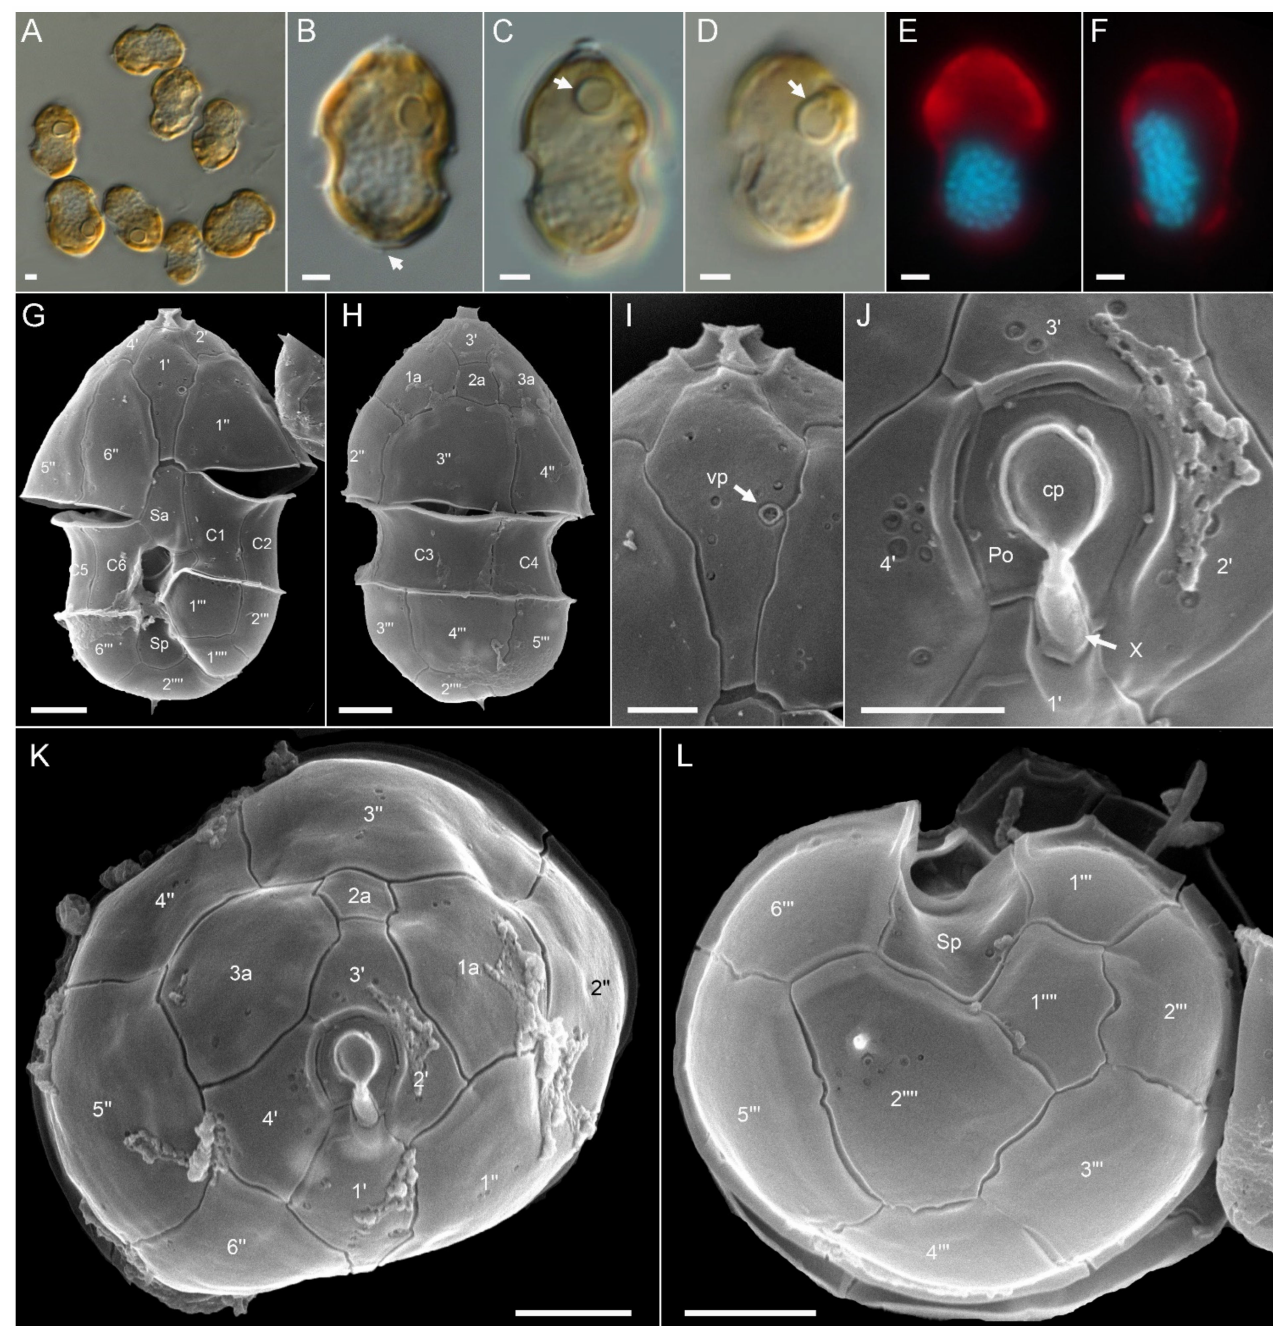
Figure 3. Azadinium spinosum ribotype A strains. ( A – D ) Light microscopy (LM) images of formalin fixed ( A , B ) or living ( C , D ) cells to indicate general size and shape. Note the antapical spine (arrow in B ) and the distinct pyrenoid in the episome (arrows in C , D ). ( E , F ) Formalin fixed and DAPI-stained cells viewed with UV excitation to indicate shape and position of the nucleus. ( G – L ) Scanning electron microscopy (SEM) images of different thecae. ( G ) Ventral view. ( H ) Dorsal view. ( I ) First apical plate in ventral view. Note the position of the ventral pore (vp). ( J ) Detailed view of the apical pore complex (APC). ( K ) Apical view of epithecal plates. ( L ) Antapical view of hypothecal plates. Plate labels according to the Kofoidian system. cp = cover plate; Po = pore plate; vp = ventral pore; X = X-plate or canal plate. Abbreviation of sulcal plates: Sa = anterior sulcal plate; Sp = posterior sulcal plate. Scale bars = 2 µ m ( A – H , K , L ) or 1 µ m ( I , J